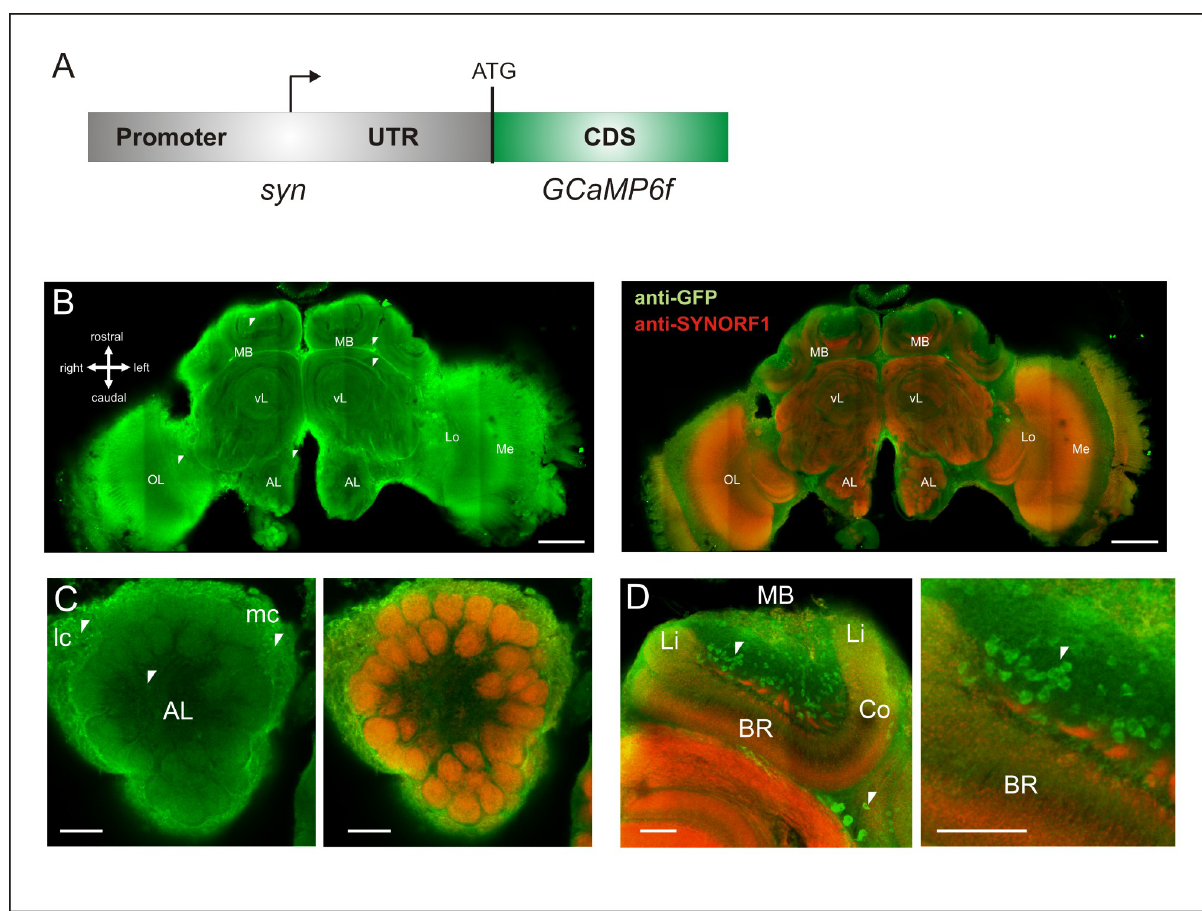
Fig 1. Genetically encoded GCaMP6f and its neural expression. ( A ) Scheme of the honey bee synapsin promoter GCaMP6f expression cassette. CDS: coding sequence; UTR: untranslated region; ATG: translation start. ( B ) GCaMP6f expression in the honey bee brain revealed by anti-GFP immunostaining (left, in green). GCaMP6f is widely expressed in the bee brain, including in somata and neural tracts (white arrows). For comparison with synapsin expression, an anti-SYNORF1 immunostaining (right, in red) is superimposed on the anti-GFP signal in green. Scale bar = 200 μ m. ( C ) GCaMP6f expression (anti-GFP in green) and synapsin expression (anti-SYNORF1 in red) in the antennal lobe. Remarkable and strong expression is observed in the somata of projection neurons and local neurons (near the AL, white arrows). Scale bar = 50 μ m. (D) GCaMP6f expression (anti-GFP in green) and synapsin expression (anti-SYNORF1 in red) in the mushroom bodies with strong expression in some somata of Kenyon cells (in the cup of the calyces, see white arrows). Scale bar = 50 μ m. AL: antennal lobe, MB: mushroom body, OL: optic lobe, Lo: lobula, Me: medulla, vL: vertical lobe, lc: lateral cluster of antennal lobe neuron somata, mc: medial cluster of antennal lobe neuron somata, Li: lip, BR: basal ring, Co: collar.